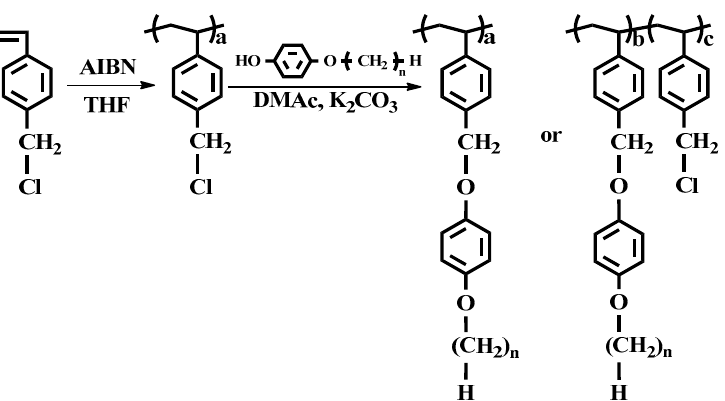
Figure 1. Synthetic route to 4-ethyloxyphenoxymethyl (PEOP# and PEOP, n = 2), 4- n -buthyloxy- phenoxymethyl (PBOP, n = 4), 4- n -hexyloxyphenoxymethyl (PHOP, n = 6), and 4- n -octyloxyphenoxymethyl-substituted polystyrene (POOP, n = 8), where # represents the molar fraction of 4-ethyloxyphenoxymethyl containing monomeric units in the polymer.